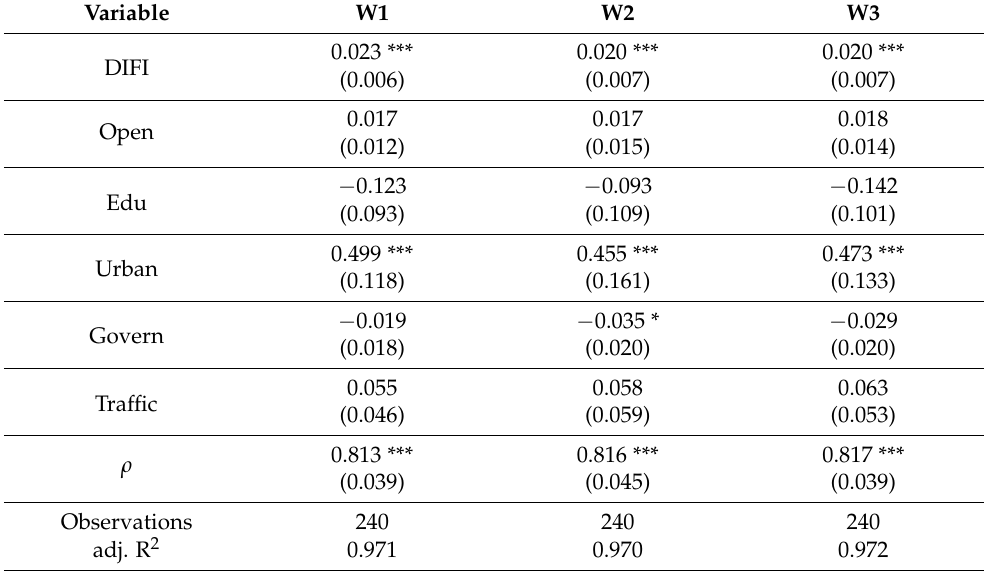
Table 6. Baseline regression results for SAR models.